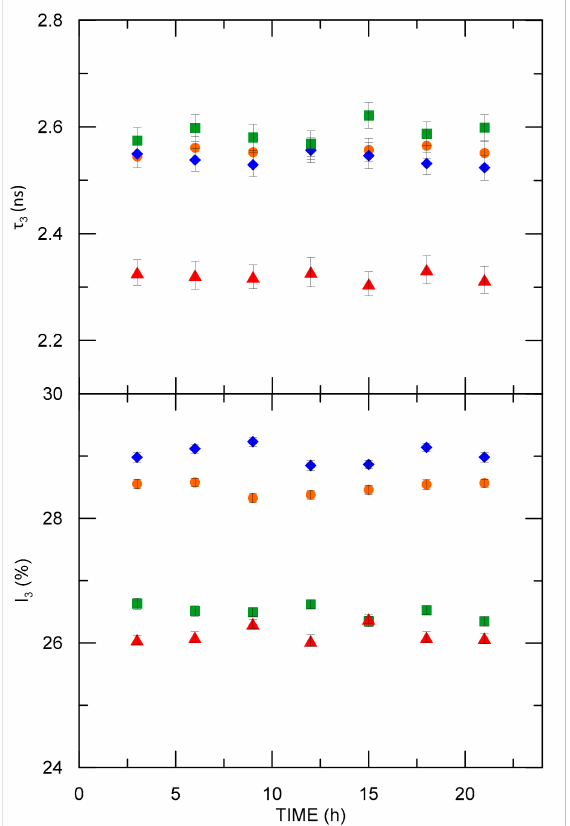
Figure 2. The o-Ps lifetime and intensity as a function of time for the four investigated sam- ples at 18 ◦ C; dots–ELO/PI, diamonds–ELO/10RD1/PI, squares–AESO/VDM, and triangles—